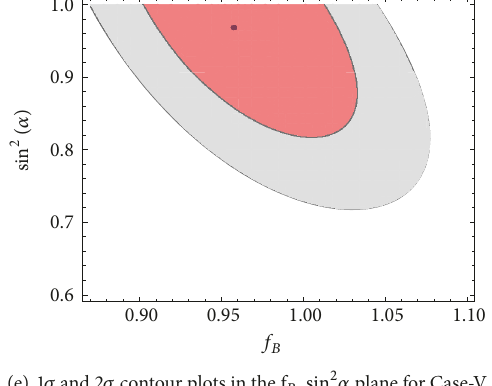
Figure 6: 1 𝜎 and 2 𝜎 contour plots for all five Cases. The dot represents the best fit point.